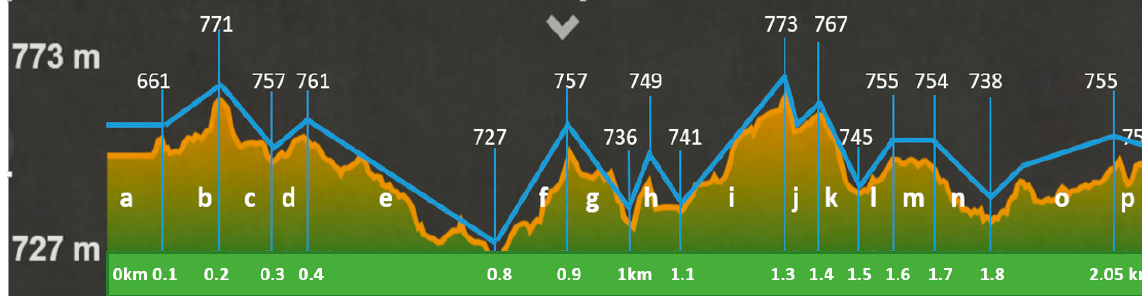
Figure 12. Riacho do Meio Altimetry trail, Araripe UGG. Source: Wikiloc; adapted for the study [40]. a–p: Route sections.